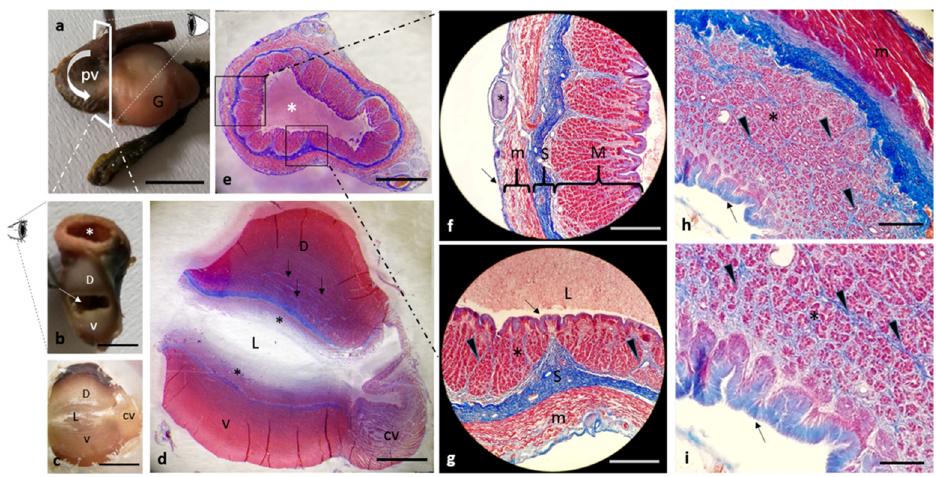
Figure 9. ( a ) Stereomicrograph: proventriculus (pars glandularis) (pv), gizzard or ventricle or pyloric stomach (pars muscularis or ventriculus) (G), transversal section plane through proventriculus (rectangle). ( b ) proventriculus small cranial part (asterisk), isthmus connecting the wider caudal part of proventriculus with ventriculus (arrow), dorsal (D) and ventral (V) ventricle muscles. ( c ) Dorsoventral/sagittal section through thick muscles of the gizzard: dorsal muscle (D), ventral muscle (V), lumen (L), cranioventral blind sac (cv). ( d – i ) Masson Trichrome with Aniline Blue staining. ( d ) Stereomicrographs of a sagittal section of the gizzard showing biconvex lens-shape: dorsal muscle (D), ventral muscle (V), lumen (L), cranioventral blind sac (cv), gastric cuticle (asterisks), connective tissue septa infiltrating the bundles of muscle fibers (arrows). ( e ) Stereomicrograph of a transversal section of proventriculus: lumen (asterisk). ( f ) Transversal sections of proventriculus: mucosa (M) submucosa (S), muscularis (m), serosa (arrow), myenteric system (asterisk). ( g ) Transversal section of proventriculus: lumen (L); epithelium (arrow); serous cardic glands (asterisk), submucosa (S), muscularis (m), Connective tissue septa (arrowheads). ( h , i ) High magnification of a sagittal section through the wider caudal part of proventriculus: glands (asterisk), epithelium (arrow), muscles (m). Scale bar: 1 cm ( a – c ), 500 μ m ( e , d ), 100 μ m ( f , g ), 50 μ m ( h , i ).